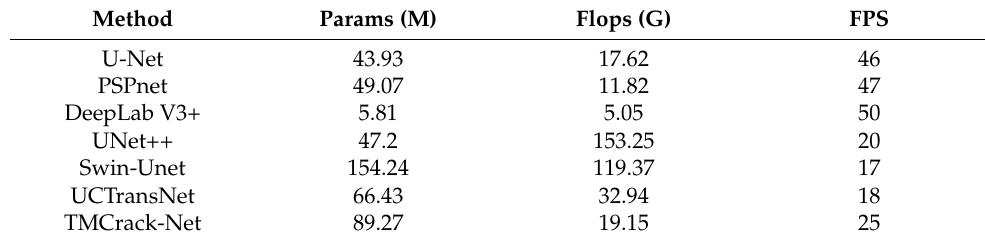
Table 7. The FLOPs, Params, and FPS of all methods on the TMCrack